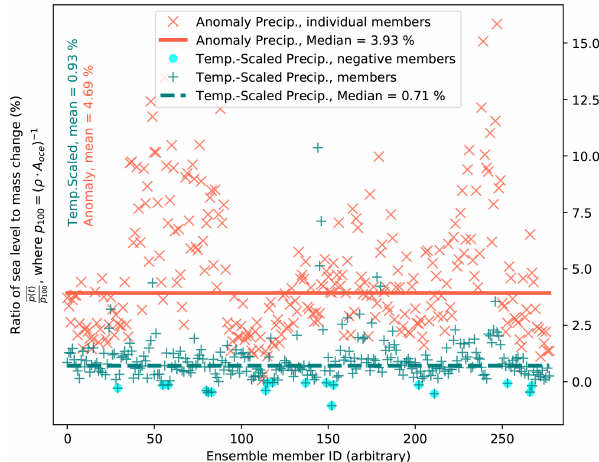
Figure E8. The ratio between the actual sea level contribution due to mass loss and the sea level equivalent of corresponding mass. Individual ensemble members are shown as crosses. A red “x” represents a member that is driven by the precipitation anomaly, and a blue-green “ + ” indicates those driven by the temperature-scaled precipitation. In the latter case, light-blue circles highlight members with negative ratios. Vertical lines mark median values for these two groups (see the legend). The corresponding mean values are listed on the left. The , where ρ is the density and A oce represents the global ocean term p ( t ) is defined by Eq. (D5) and p 100 = 1 ρ · A oce